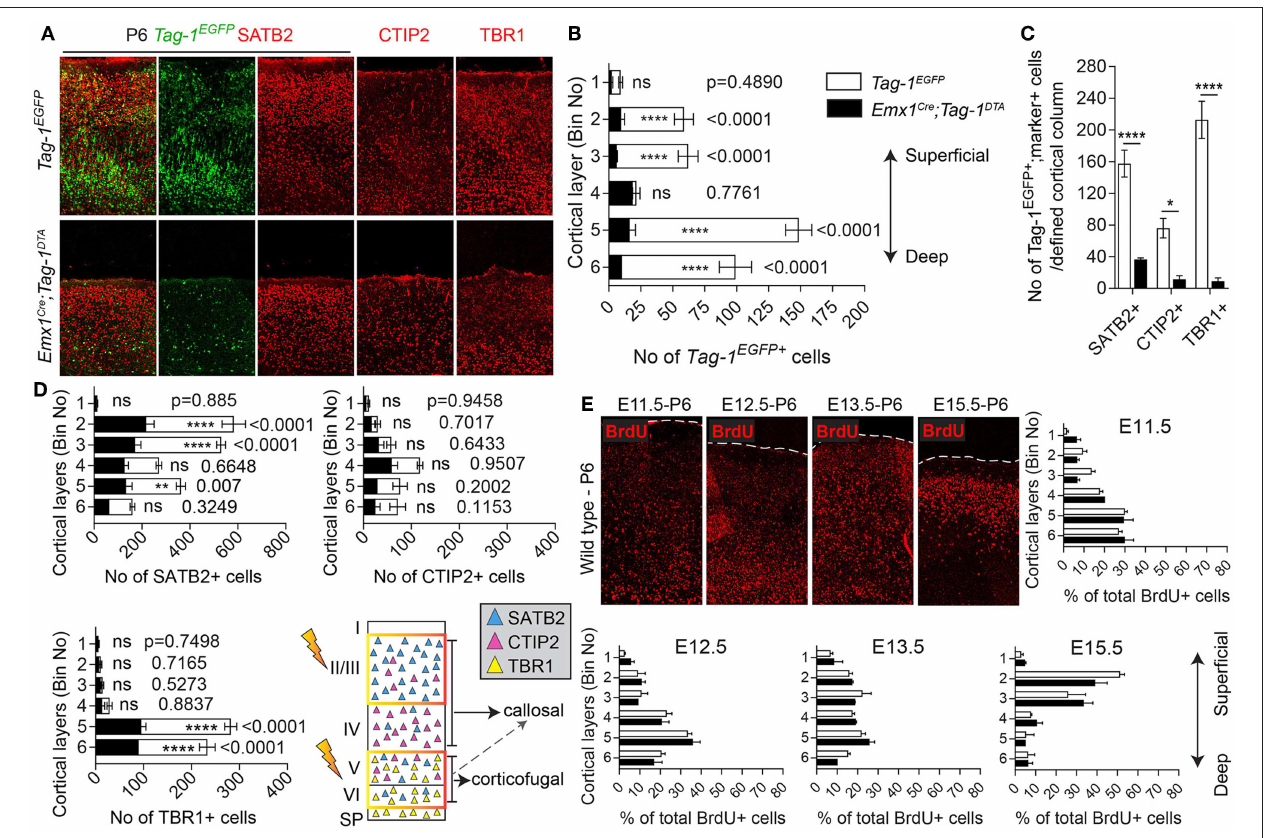
FIGURE 6 | Targeted ablation of TAG-1 + cortical neurons results in neuronal reduction throughout the cortex. (A) Immunofluorescent analysis of the expression of the Tag-1 loxP − EGFP − loxP − DTA transgene in the somatosensory cortex at P6 and the layer markers SATB2, CTIP2, and TBR1 in Tag-1 EGFP and Emx1 Cre ;Tag-1 DTA mice. (B,C) Crossing of Emx1 Cre with Tag-1 loxP − EGFP − loxP − DTA and analysis at P6 results in a substantial decrease of Tag-1 EGFP + cells in layers II/III, V and IV, corresponding to all three SATB2 + , CTIP2 + , and TBR1 + subpopulations. In (B) , data are represented as mean ± SEM, N = 4 and 3 respectively, and the populations of EGFP + cells in the Tag-1 EGFP and Emx1 Cre ;Tag-1 DTA somatosensory cortex are shown superimposed. In (C) , data are represented as mean ± SEM and respectively for Tag-1 EGFP and Emx1 Cre ;Tag-1 DTA , for SATB2: N = 4 and 3, for CTIP2: N = 3 and 4, for TBR1: N = 5 and 4. (D) Upon ablation of TAG-1 + pyramidal neurons of the dorsal telencephalon, a significant decrease is observed in the total numbers of SATB2 + neurons of upper and deeper layers and CTIP2 + and TBR1 + neurons of deeper layers. The scheme is depicting the layers which were the most affected upon ablation (orange frame). In (D) , data are represented as mean ± SEM with stacked values for Tag-1 EGFP and Emx1 Cre ;Tag-1 DTA and respectively for Tag-1 EGFP and Emx1 Cre ;Tag-1 DTA , for SATB2: N = 4 and 3, for CTIP2: N = 3 and 4, for TBR1: N = 5 and 4. In (C) , for EGFP + ;SATB2 + cells, P < 0.0001, for EGFP + ;CTIP2 + , P = 0.013 and for EGFP + ;TBR1 + , P < 0.0001. (E) BrdU detection and quantification in the somatosensory cortex of P6 mice following BrdU pulse-labeling at either E11.5, E12.5, E13.5, or E15.5 in Tag-1 EGFP and Emx1 Cre ;Tag-1 DTA mice. Data were plotted as mean ± SEM. Differences were not statistically significant (for pulses at E11.5, E12.5, and E15.5, P > 0.05, N = 3, for pulses at E13.5, P > 0.05, N = 2). ns, non-significant; * p < 0.05, ** p < 0.01, *** p < 0.001, **** p <